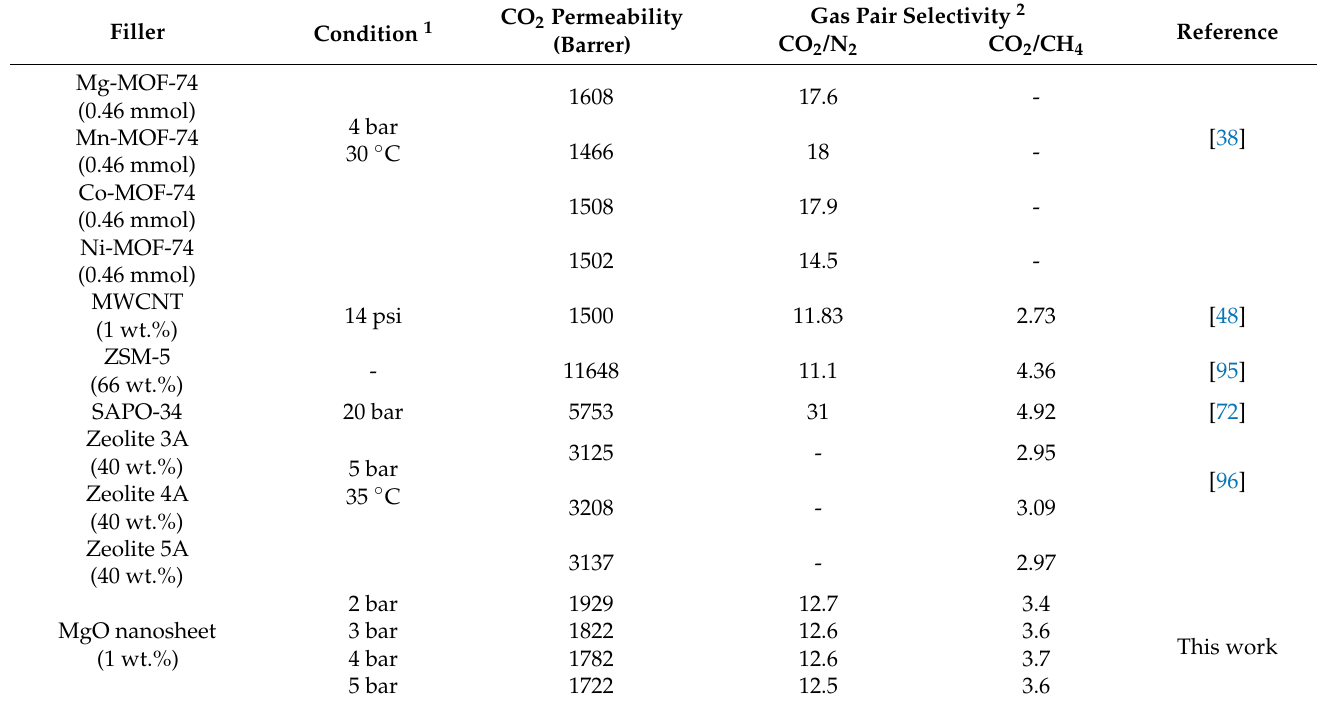
Table 2. Gas performance comparison of PDMS MMM with other